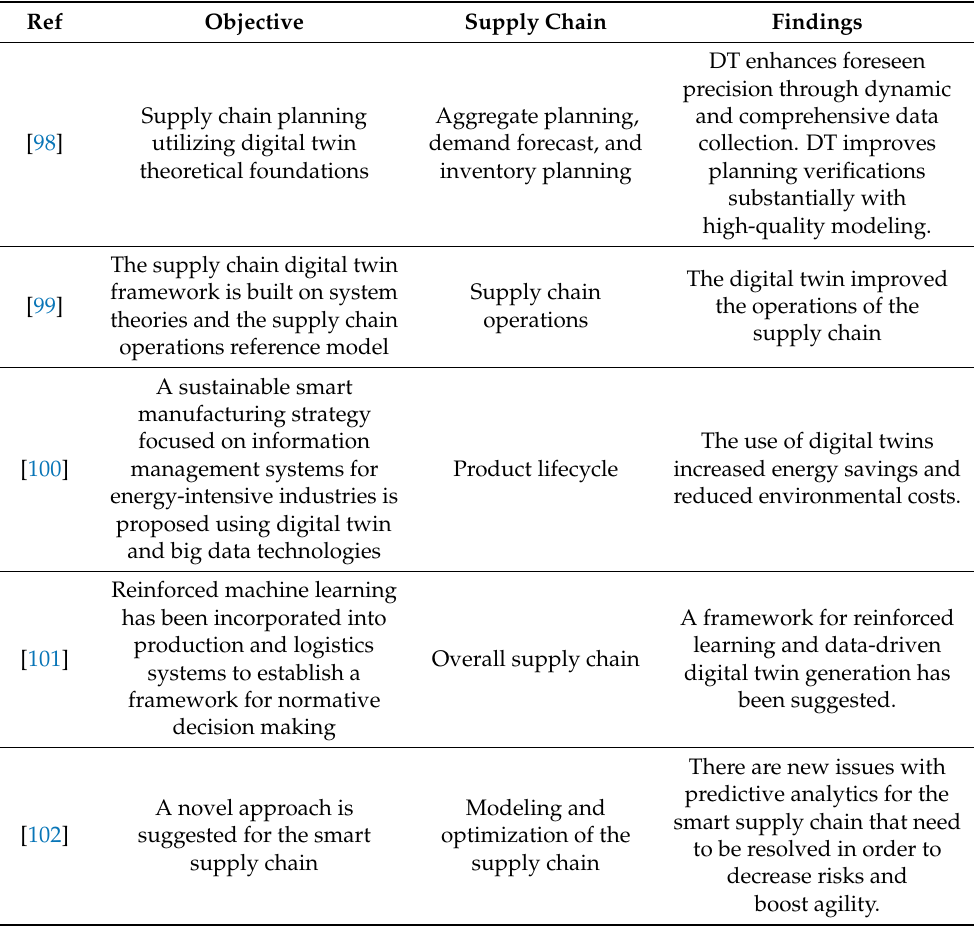
Table 5. Digital twin for sustainable